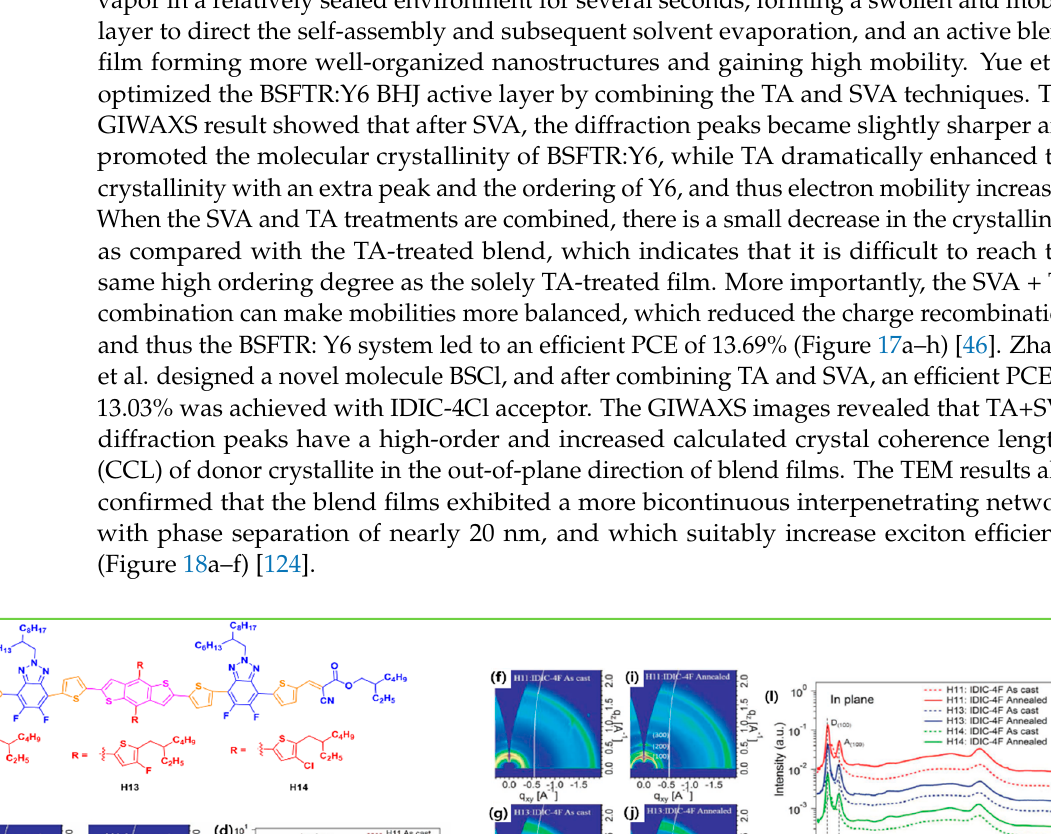
Figure 17. ( a ) Chemical structure of BSFTR donor. ( b , c ) J − V and EQE curves for SMSCs based on BSFTR and Y6 with different post-treatments under AM 1.5 G irradiation. ( d – g ) Two-dimensional GIWAXS patterns and ( h ) out-of-plane and in-plane scattering profiles of the blend films without and with post-treatments. Adapted with permission from [46]. Copyright 2019, John Wiley and Sons.